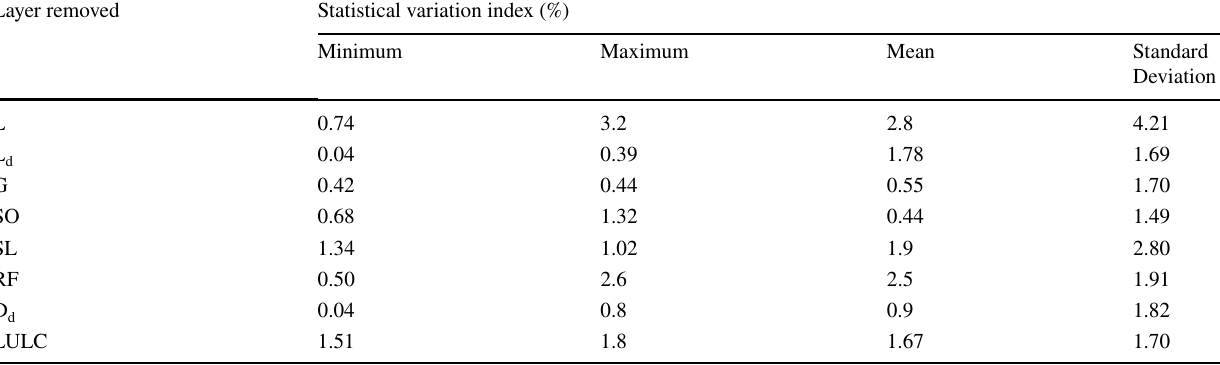
Table 9 Statistics of map removal sensitivity analysis